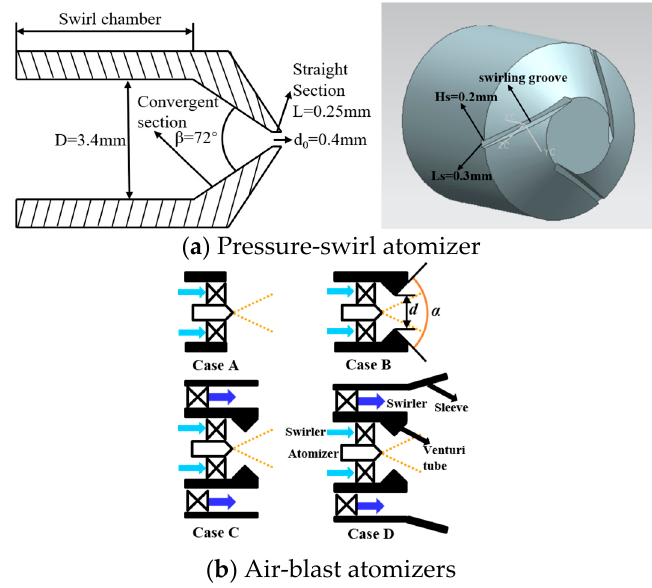
Figure 1. Schematic of ( a ) pressure-swirl atomizer and ( b ) air-blast atomizers.